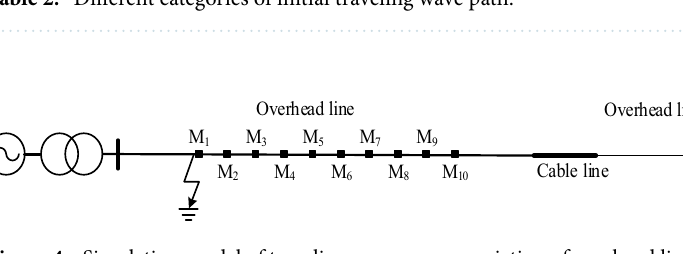
Table 2. Different categories of initial traveling wave path.